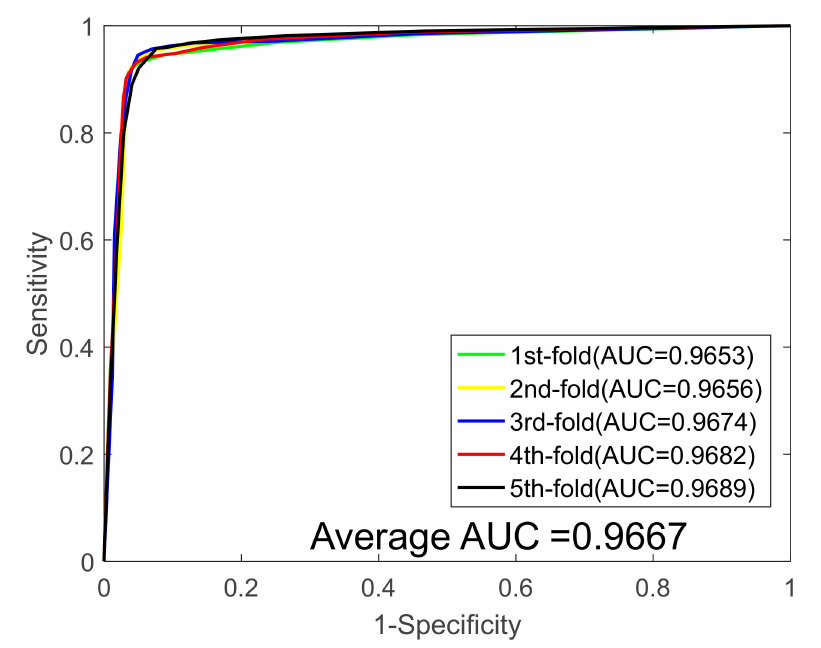
Figure 3. ROC curves generated by the proposed model on the Oryza sativa